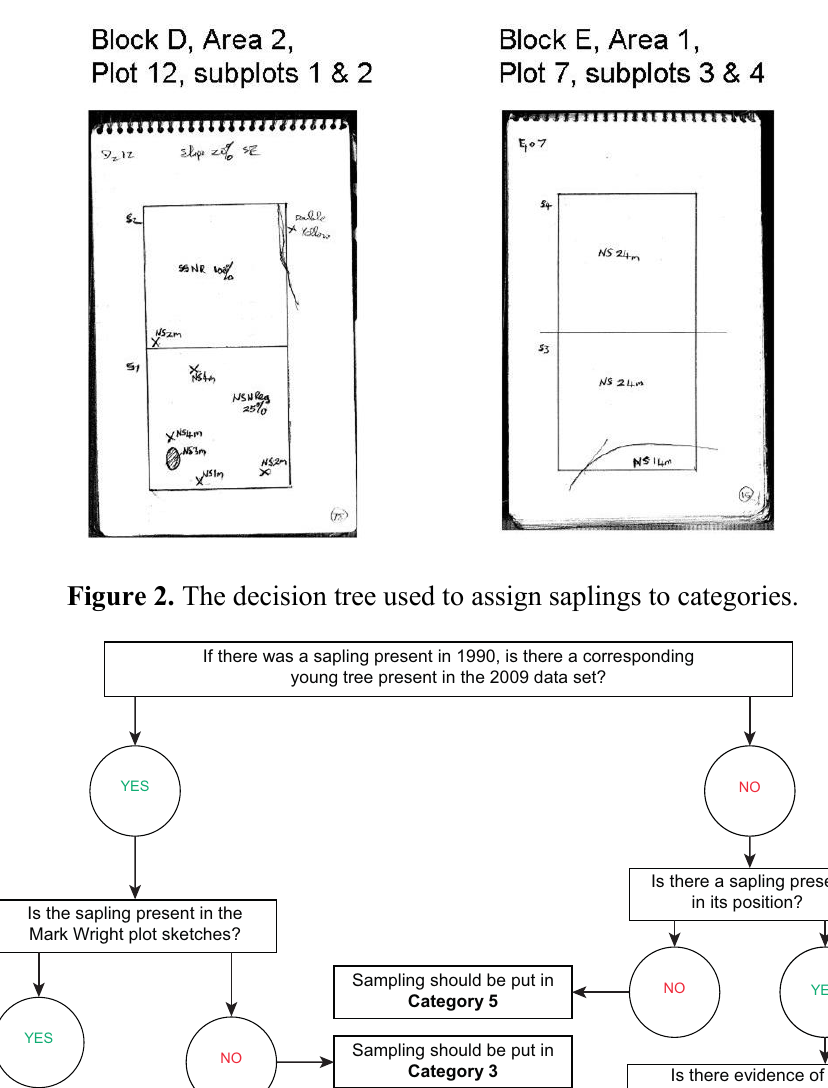
Figure 1. Plot sketches for subplots in management areas D and E.